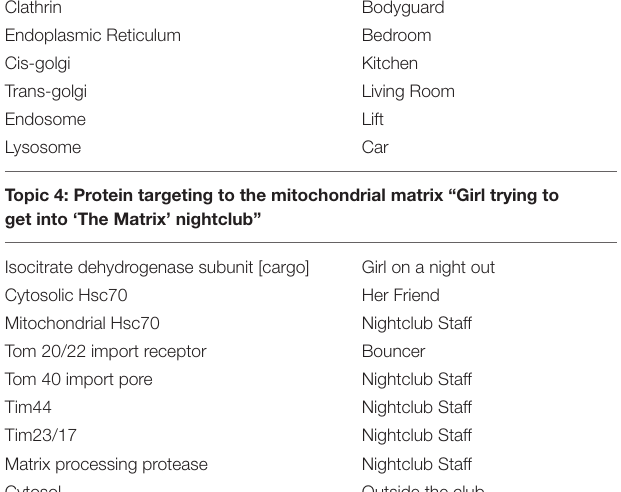
voting form as well as the excel file template are provided as Supplemental Files S1 , S2